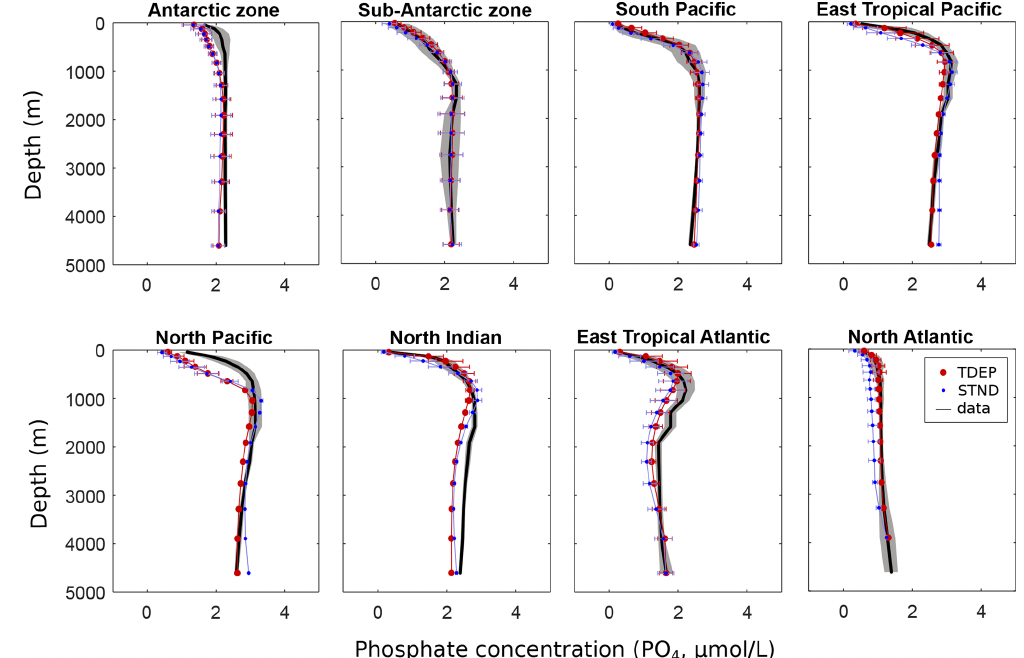
Figure 7. PO 4 (µmolL − 1 ) per depth by region for the model and data (mean and standard deviation). Data from WOA 2009 (Levitus et al., 2010). STND is the standard model, an TDEP is the temperature-dependent